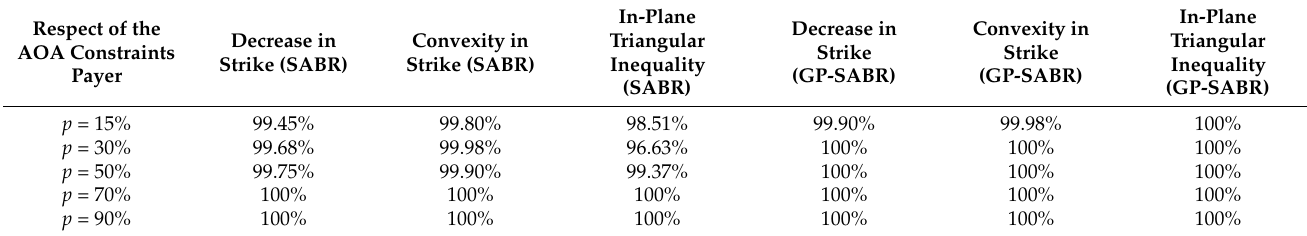
Table 9. Respect of the no-arbitrage constraints for the predicted OTM payer swaptions priced by the SABR model calibrated on observations or on the output of the GP model, for increasing sizes of training set.